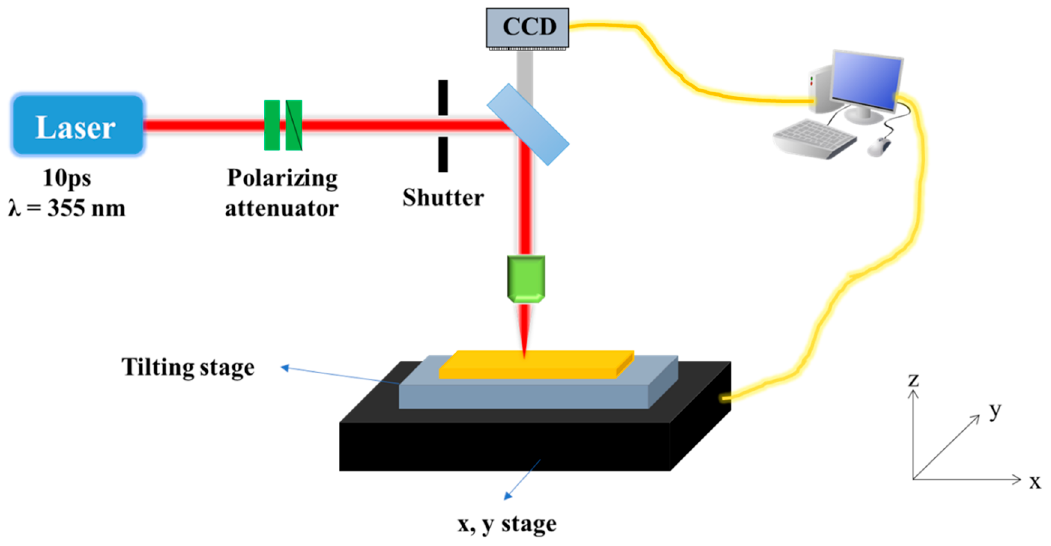
Figure 1. Schematic diagram of a laser processing system for a polymer material.